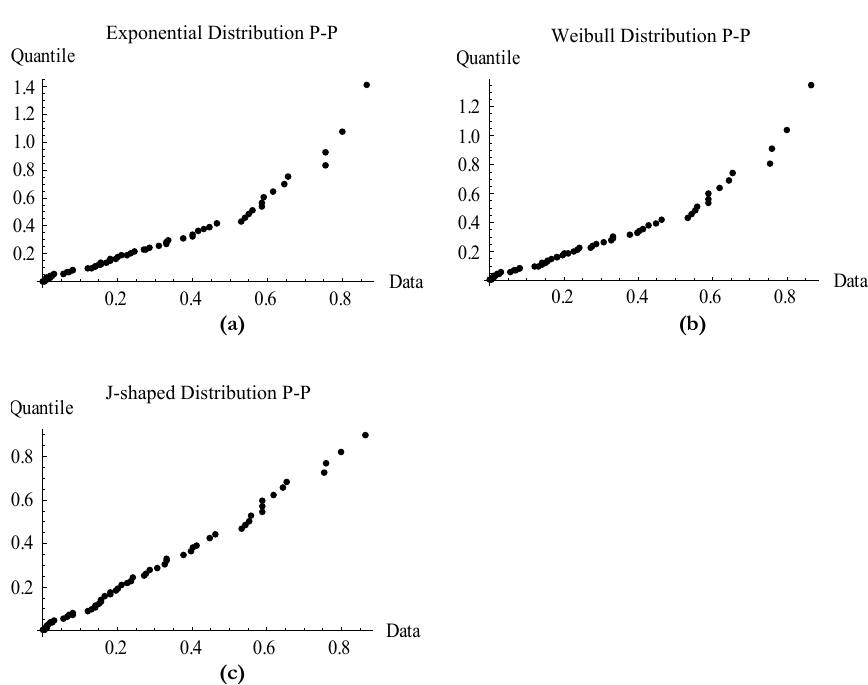
Figure 1(a)-(c) – Probability plots for failure data assuming exponential, Weibull, and J-shaped distri-